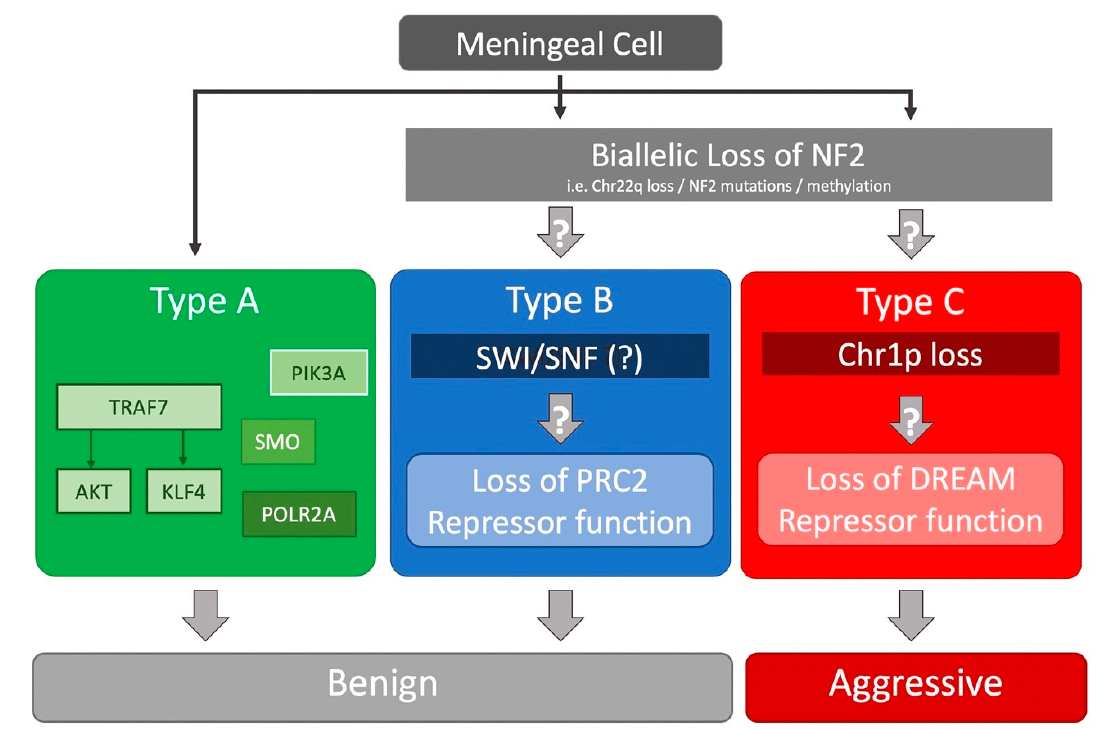
Figure 1. Summary of the mutational landscape of meningiomas based on several next-generation sequencing studies.